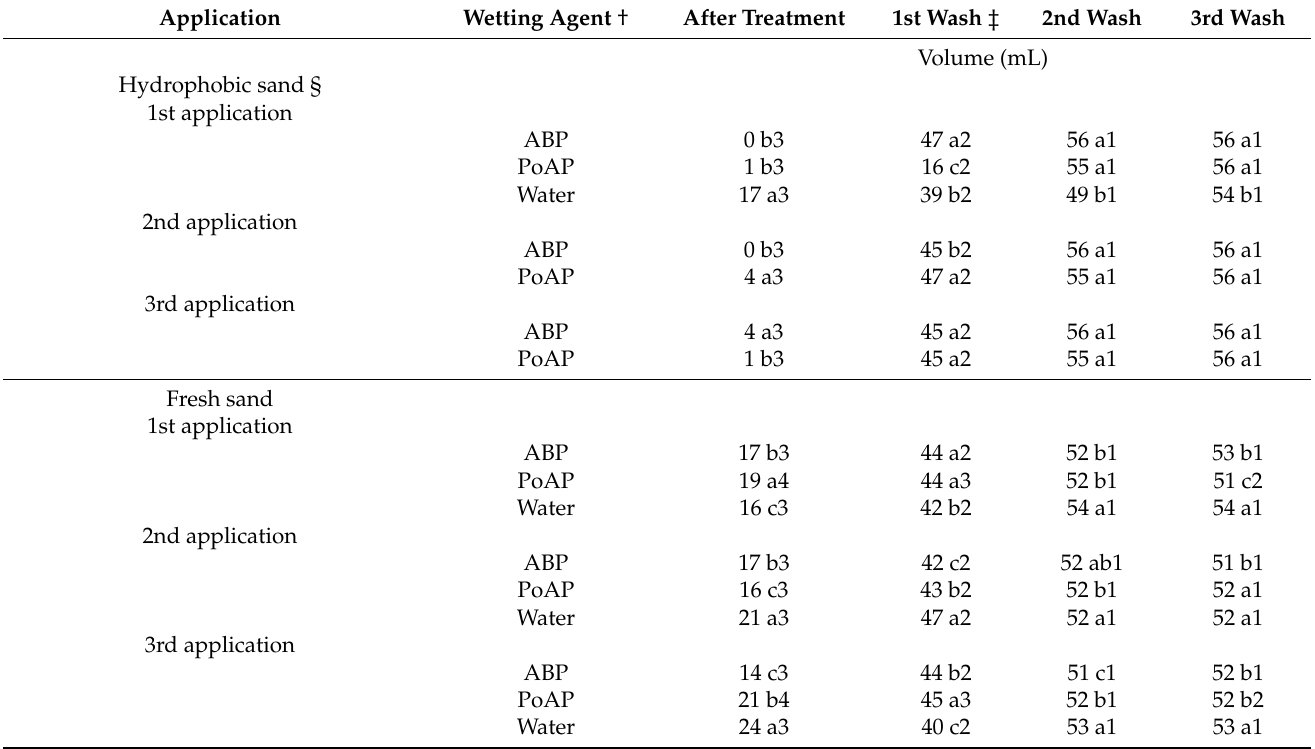
Table 2. Treatment effects on leachate volume (mL) of hydrophobic and fresh sand systems after. the first, second, and third wetting agent applications and three sequential washes following each